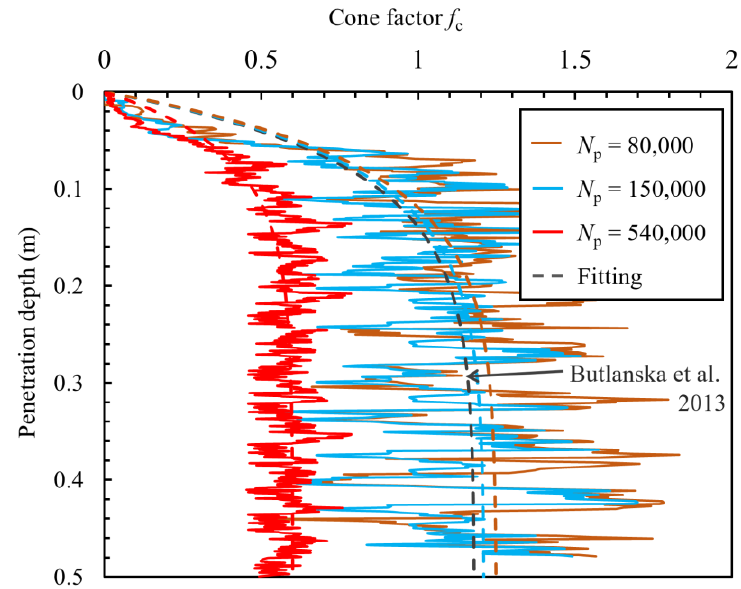
Figure 10. Cone factors predicted by DEM simulations.